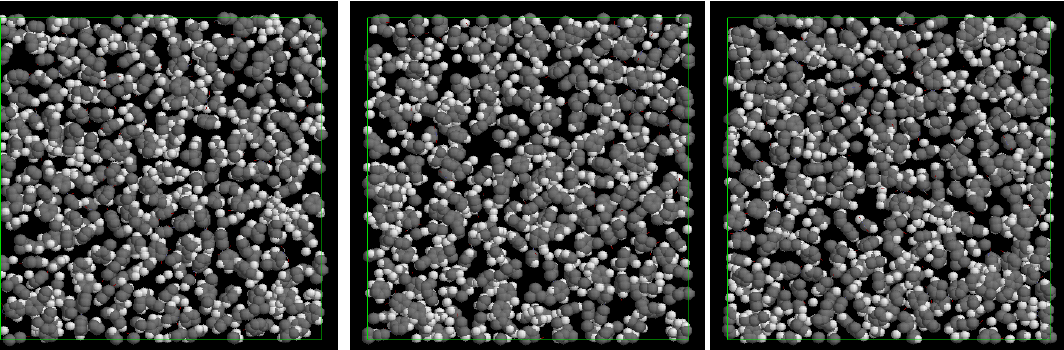
Figure 3. Visualization of free volume in Ultem, the density is 1.279 g/cm 3 . Successive slices in the range 0–10.5 Å.